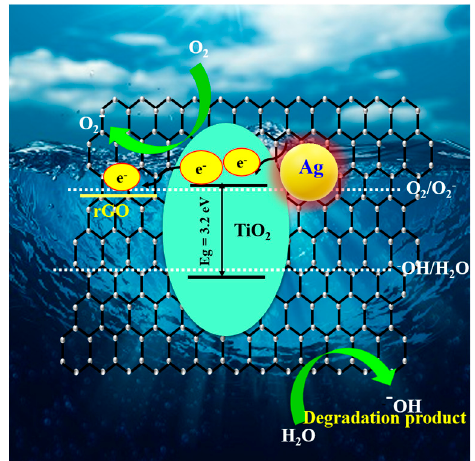
Figure 6. Schematic illustration of the possible mechanism of rGO, Ag NPs roles with mesosphere TiO 2 in MB photocatalytic degradation under natural sunlight irradiation.